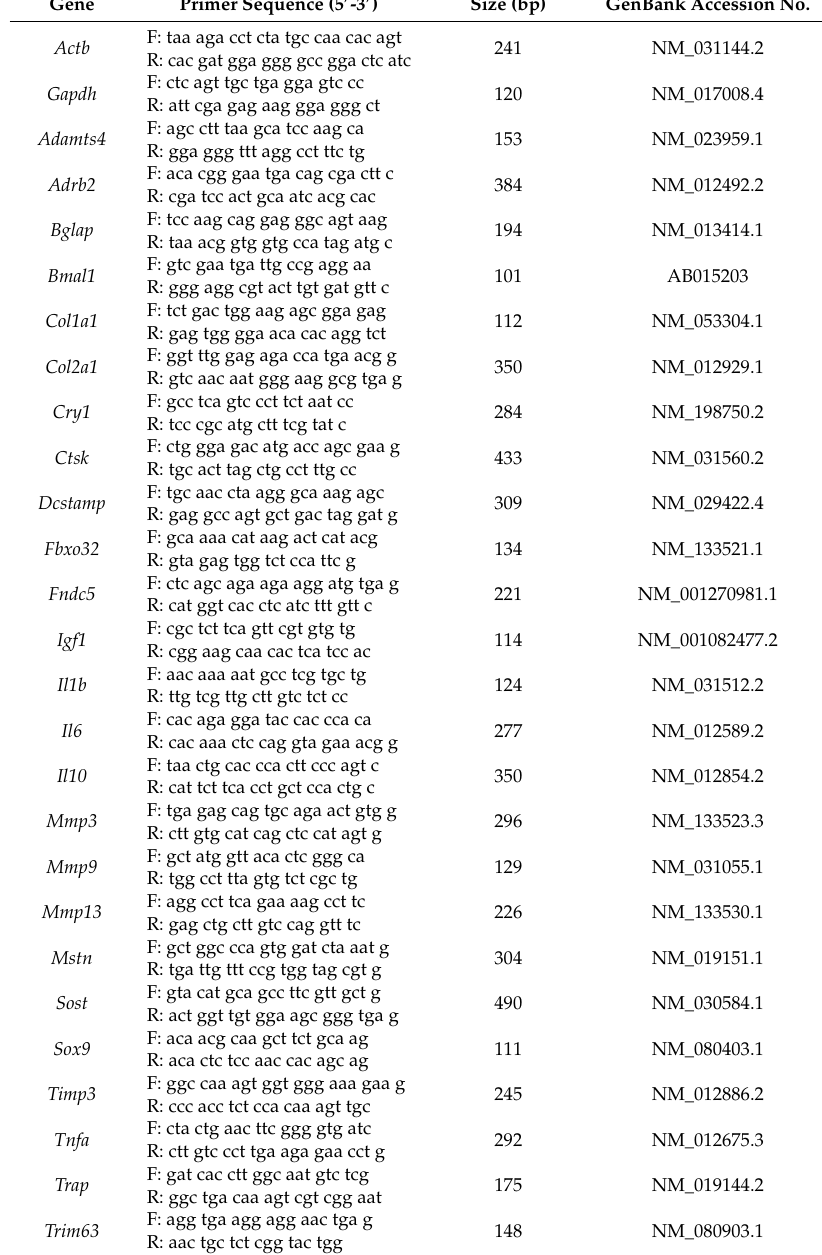
Table 1. Oligonucleotide primers used for